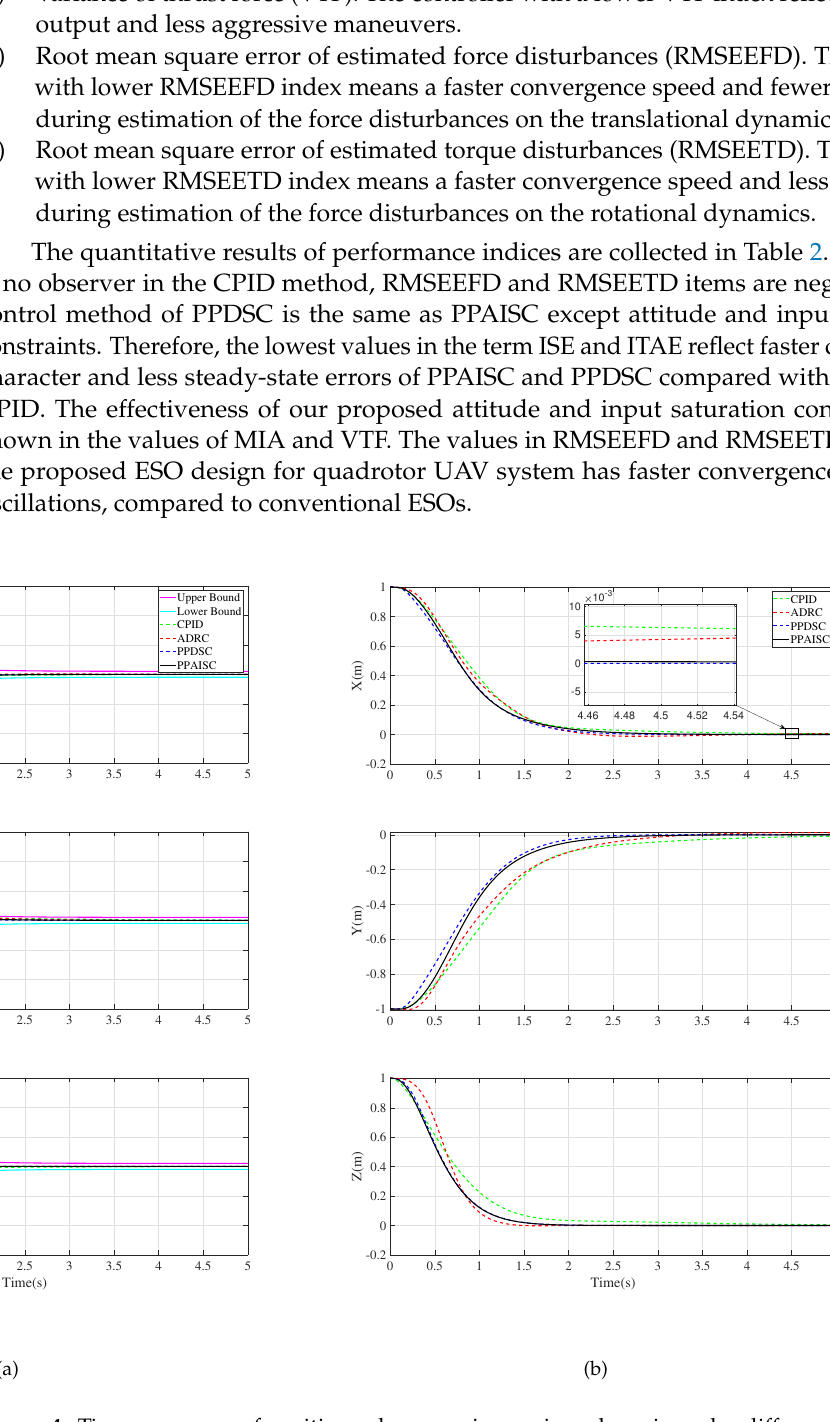
Figure 4. Time responses of positions along x -axis, y -axis and z -axis under difference controllers. ( a ) Positions with upper and lower bounds of prescribed performance function. ( b ) Position